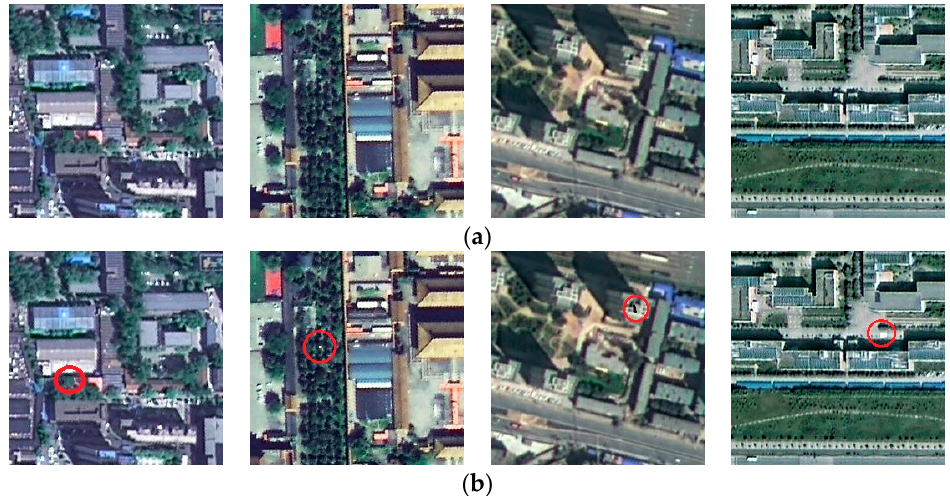
Figure 13. Tampering examples of removing object: ( a ) Original HRRS images, ( b ) corresponding tampered images.